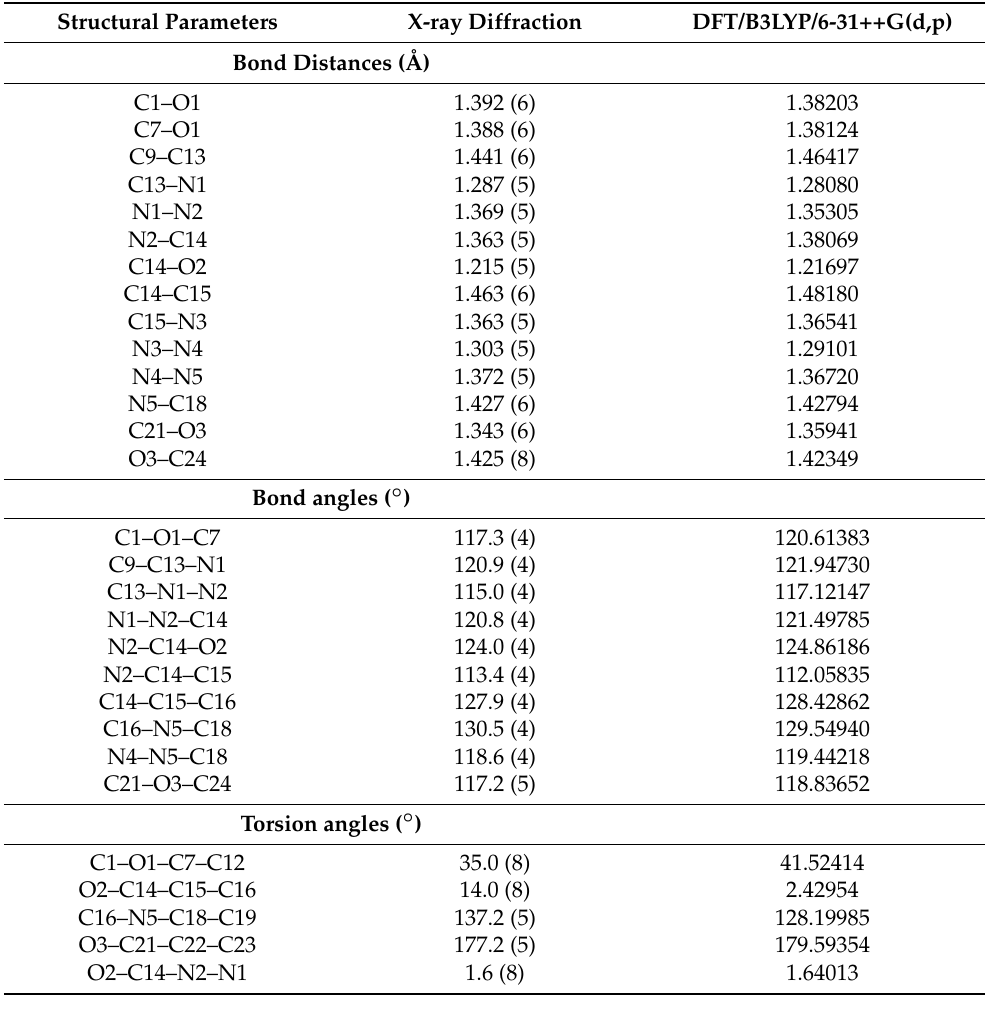
Table 2. Some selected bond distances, bond angles, and torsion angles of 2